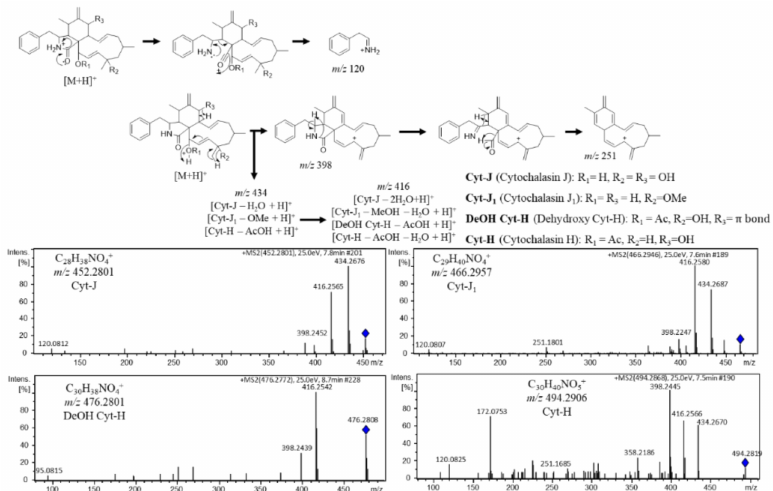
Figure 2. Cytochalasin (Cyt) annotations based on ESI-(+)-HRMS-MS fragmentation mechanisms. The blue diamond inside MS 2 spectrum represents the precursor